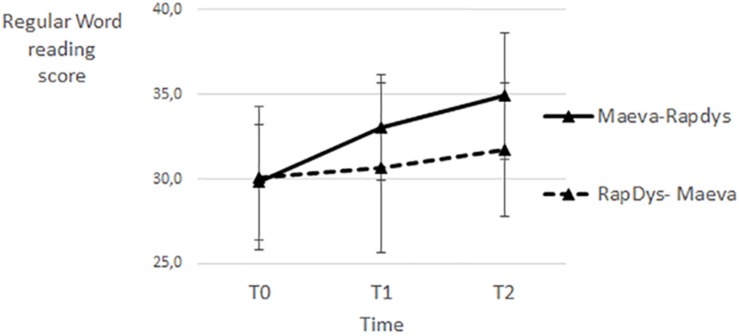
Regular word reading scores for each time period and each presentation order.